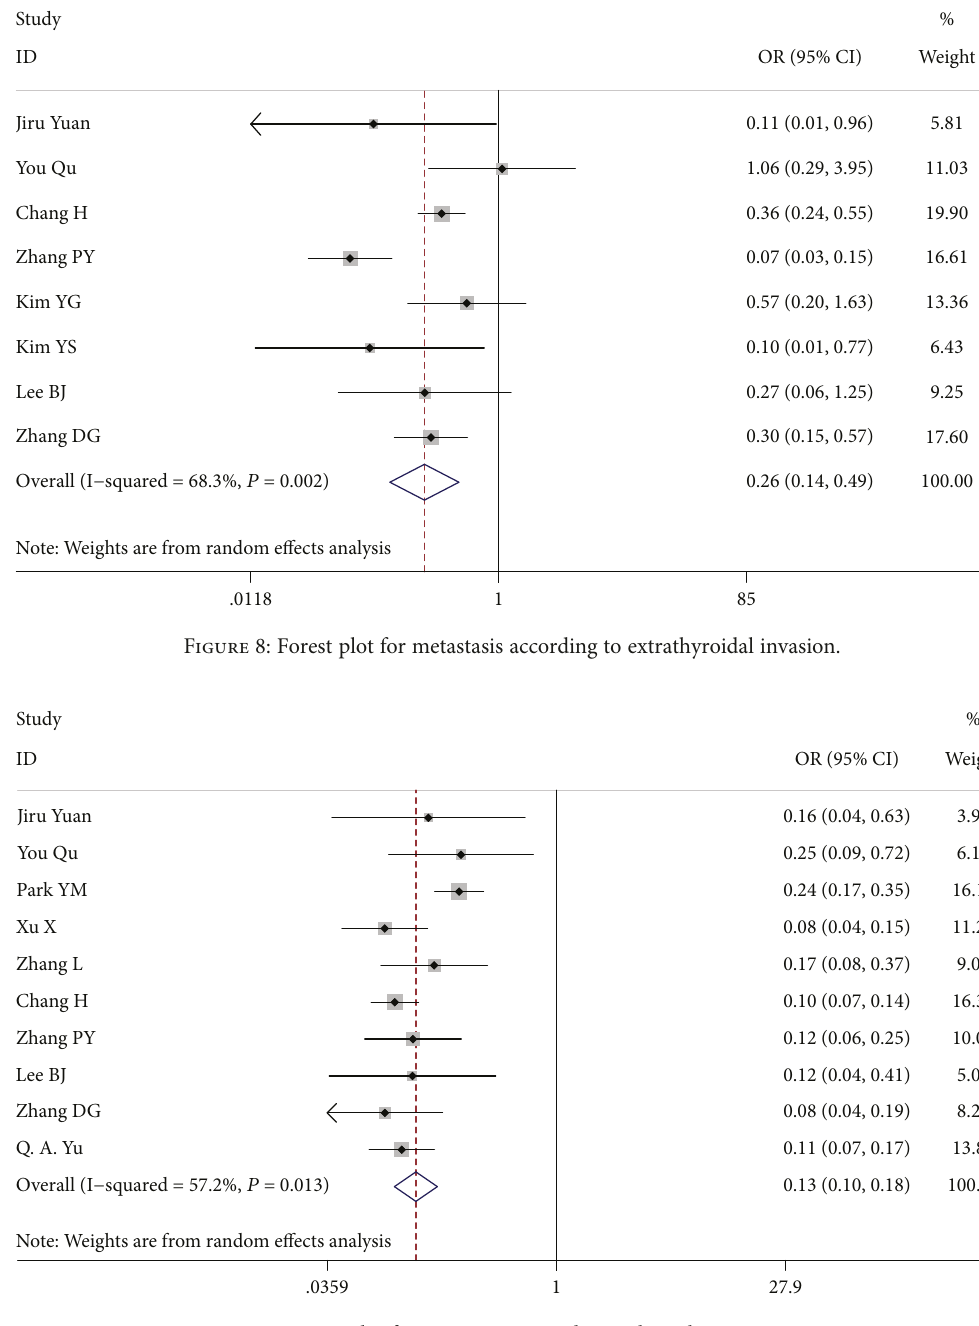
Figure 9: Forest plot for metastasis according to lateral LN